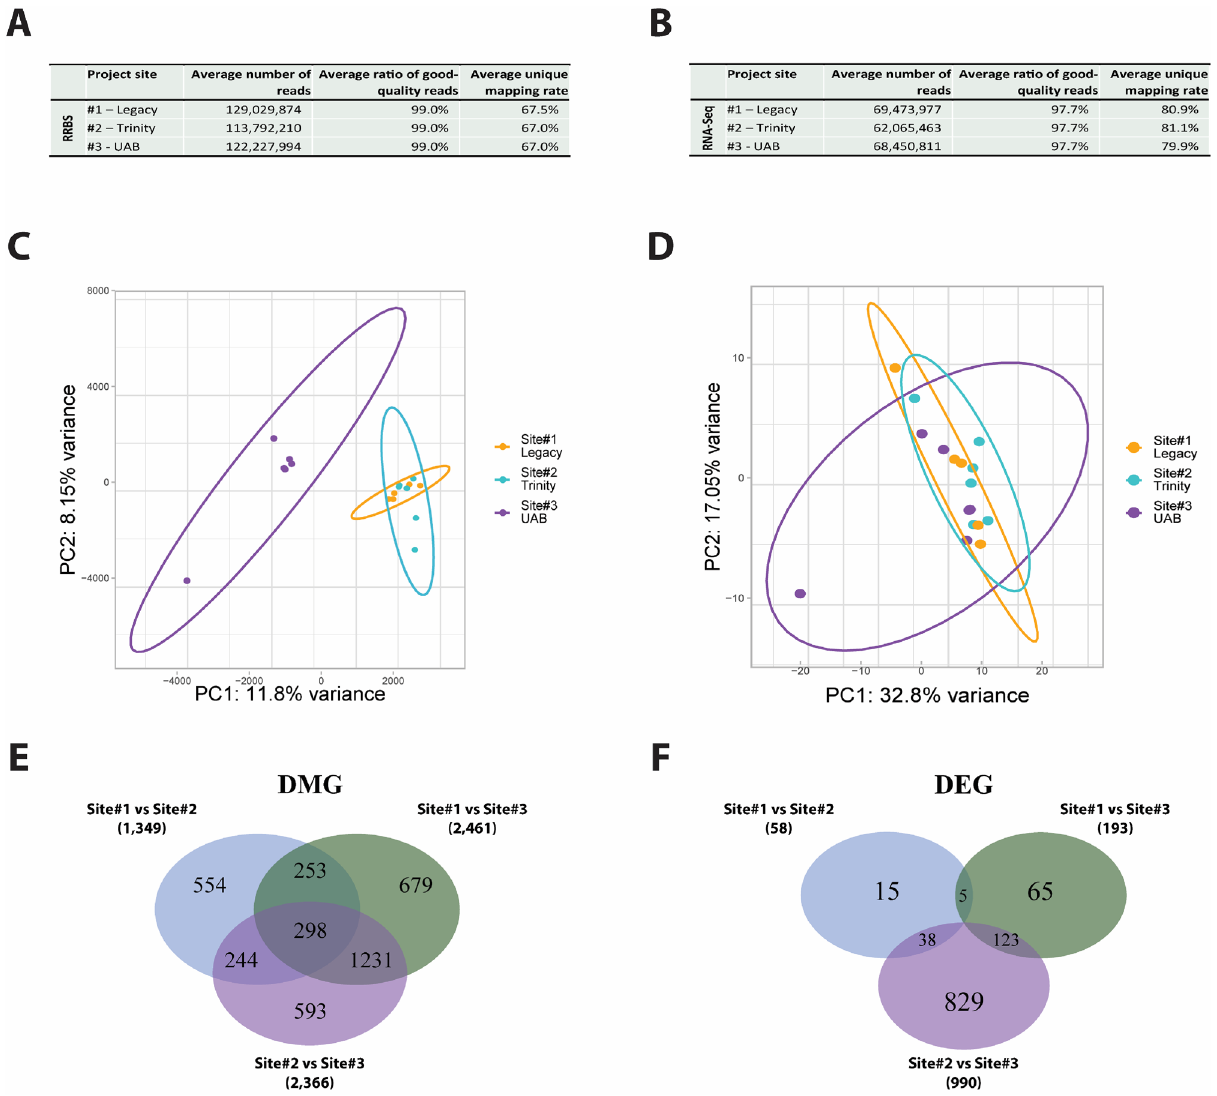
Figure 2. RRBS and RNA-Seq summary. The average number of sequencing reads, the average ratio of good quality reads, and the average unique mapping rates per sample are given for RRBS ( A ) and RNA-Seq ( B ). Principal component analysis (PCA) on RRBS ( C ) and RNA-Seq ( D ) was performed to examine the overall similarity among the samples. Differentially methylated genes (DMGs; [ E ]) and expressed genes (DEGs; [ F ]) were obtained between each pair of project sites and compared among the sets. Panel images were created using R